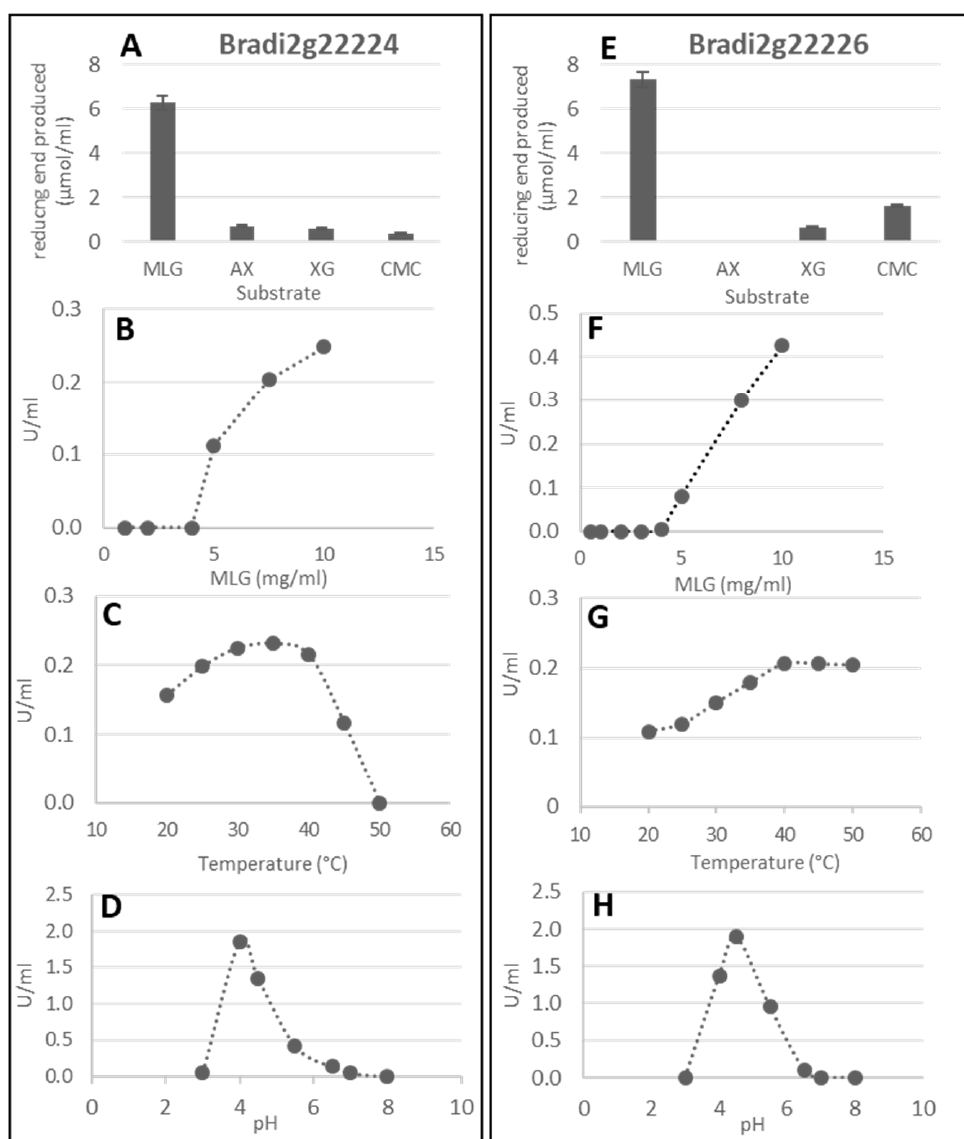
Figure 5. Enzymatic activity of the recombinant enzymes encoded by Bradi2g22224 and Bradi2g22226. Enzymes were incubated with 10 mg/mL of substrate during one night for substrate specificity determination ( A , E ) or 2 h for other kinetics based on substrate concentration ( B , F ), temperature ( C , G ), and pH ( D , H ). MLG: barley mixed linkage glucan; AX: wheat arabinoxylans; XG: tamarin xyloglucan; CMC: carboxymethylcellulose.